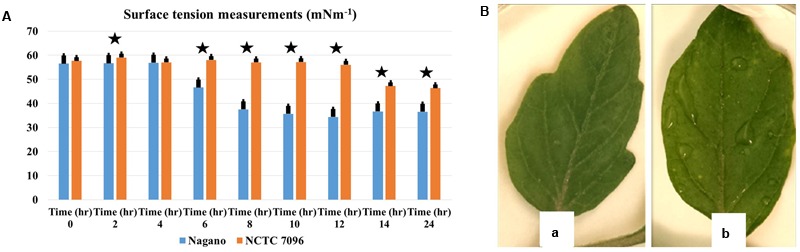
Aneurinibacillus migulanus biosurfactant effects on surface tension of culture fluids and wetness of tomato leaves. (A) Time course of changes in surface tension of () A. migulanus Nagano and () A. migulanus NCTC 7096 culture fluids. Vertical bars represent standard errors of the means, (N = 3). (B) Effects of A. migulanus Nagano (a) and NCTC 7096 (b) on surface wetness of tomato leaves. Data presents mean ± standard error. Bars labeled with asterisk are significantly different among the treatments at P < 0.05 using ANOVA analysis.